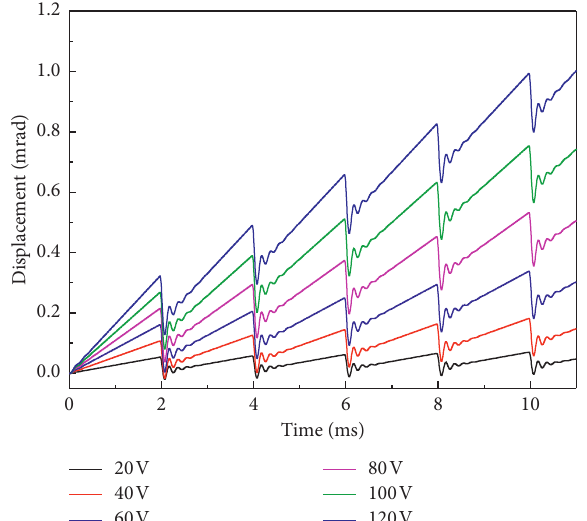
Figure 8: Simulation results of rotation displacement of the PA under 500Hz sawtooth waveform at different amplitudes.